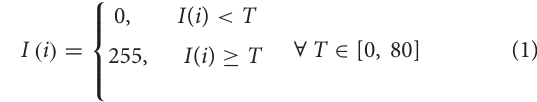
images. The cameras were calibrated using OPENCV library in Python and the resulting parameters were used to correct the extracted